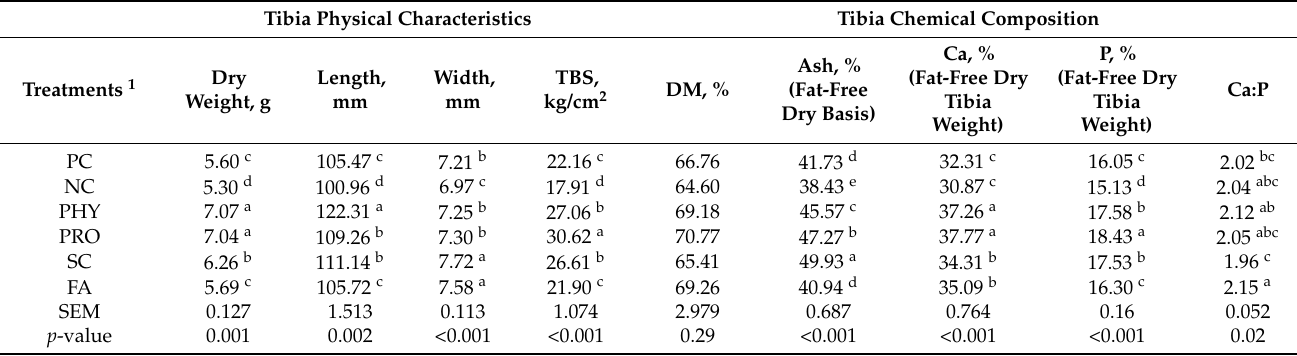
Table 8. Tibia physical traits and mineralization of broiler chickens fed a reduced nPP diet supple- mented with phytase, probiotic, Saccharomyces cerevisiae , and fumaric acid at 35 days of